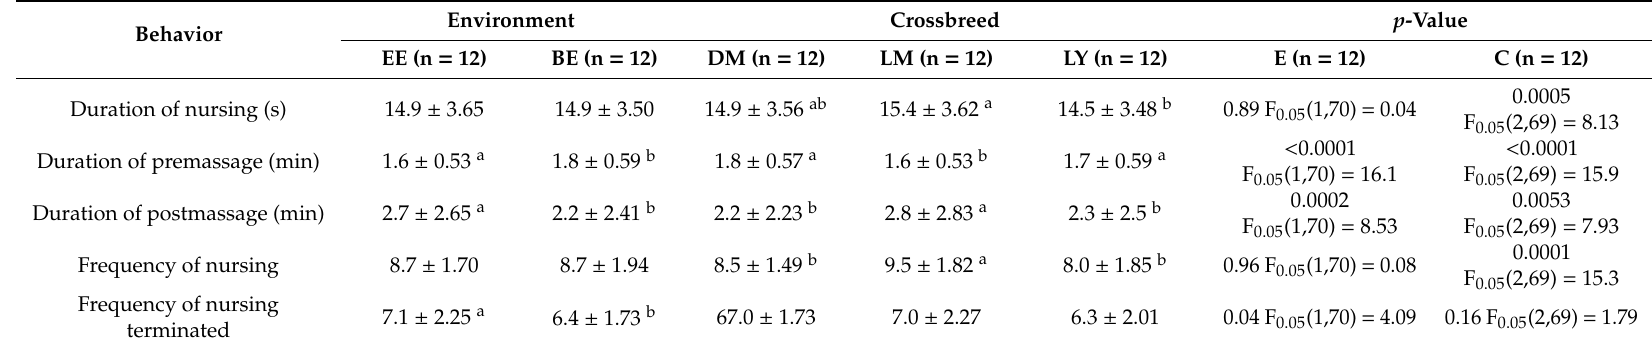
Table 5. Nursing behavior of sows from weeks 2 to 5